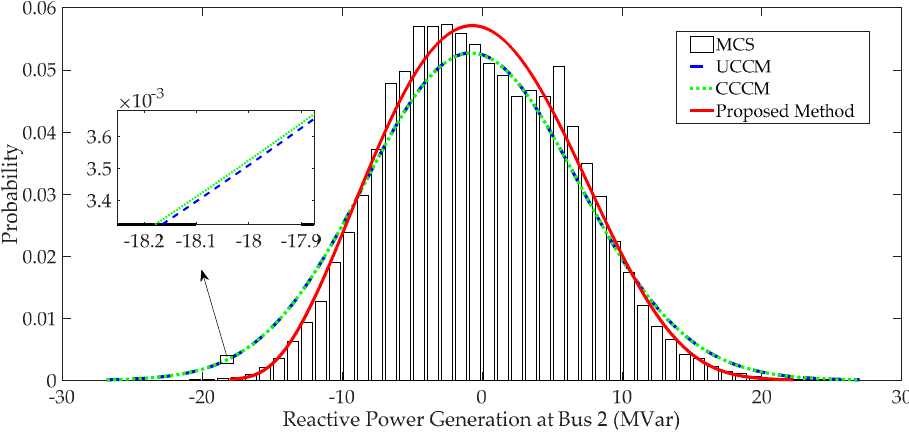
Figure 6. PDFs of reactive power generation at bus 2 (modified IEEE 9-bus test system).